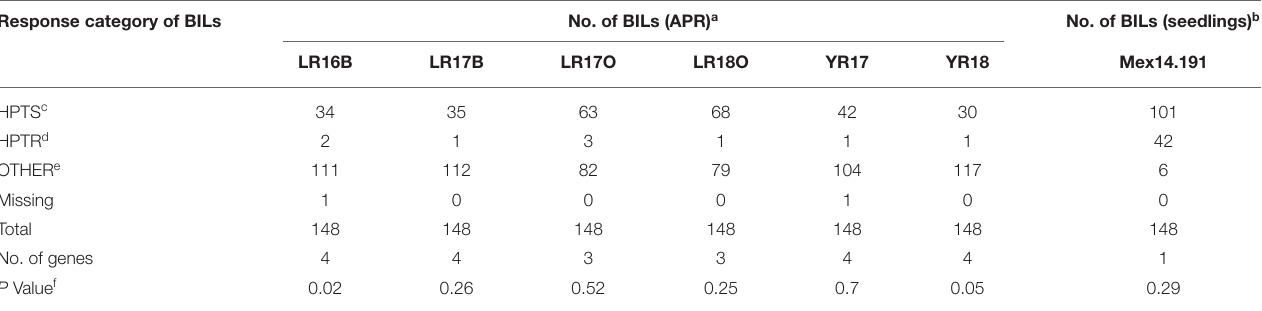
TABLE 1 | Estimated number of resistance genes that confer seedling resistance to stripe rust and adult plant resistance to leaf rust and stripe rust in 148 KU3067 × Apav BILs based on Mendelian segregation analysis. Response category of BILs